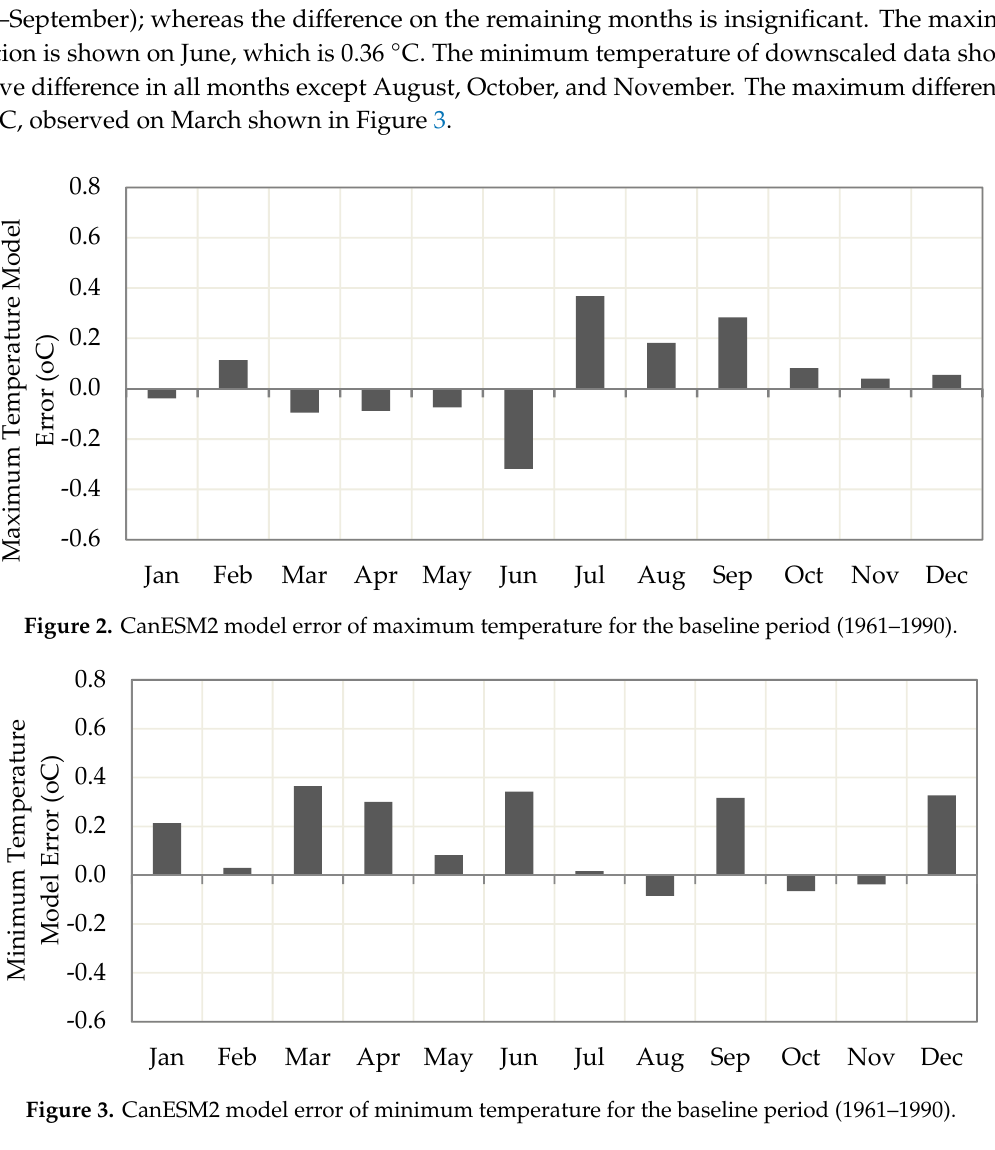
Figure 3. CanESM2 model error of minimum temperature for the baseline period (1961–1990).